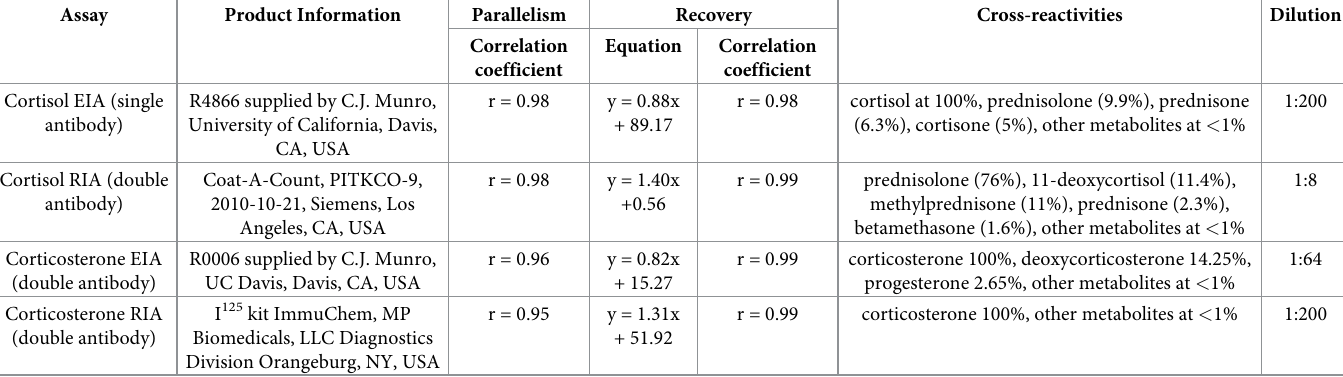
Table 2. Immunoassays used to evaluate fecal samples from an adrenocorticotrophic hormone challenge (ACTH). Results indicated a high correlation for both vali- dation methods used; parallel displacement curves and recovery of the standards. Cross-reactivities of each assay with associated glucocorticoid metabolites are indicated as well as the optimal dilution used for samples on each